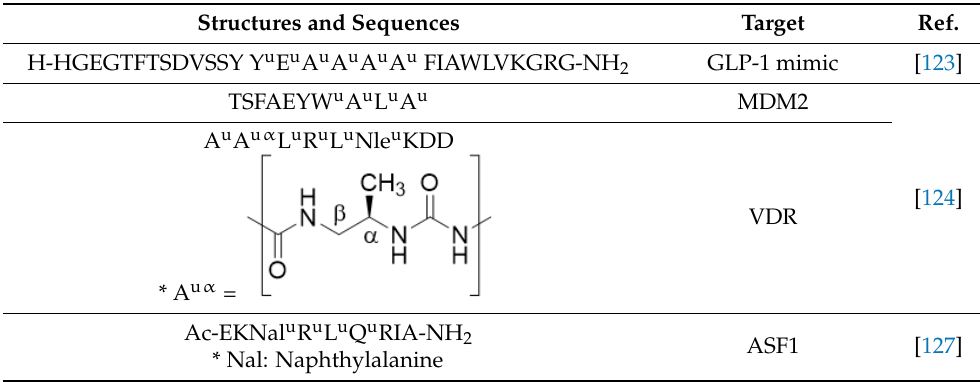
Table 5. Urea-based foldamers and their applications. Structures and Sequences Target